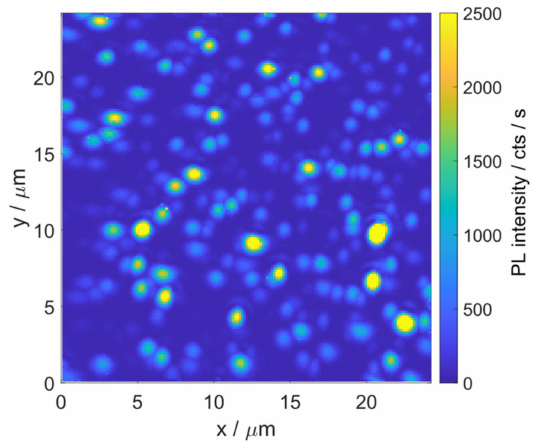
Figure A4. Exemplary µ -PL map of the photonic sample, measured at 4 K. The spectrometer ranges from 767 nm to 810 nm.